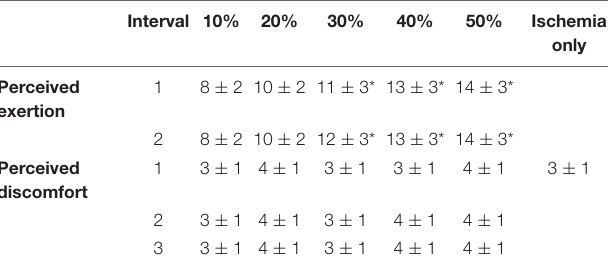
TABLE 2 | Participants’ rating of perceived exertion (Borg scale = 6–20) during each contraction and rating of discomfort (0–10) during post-exercise ischemia (PEI), or during ischemia